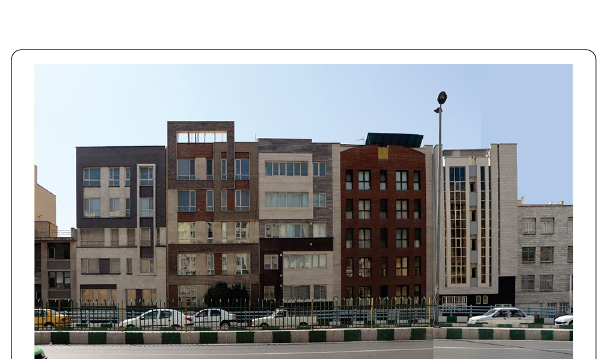
Fig. 3 The urban facade buildings of the Islamic Republic period in Tehran, Shahid Gomnam